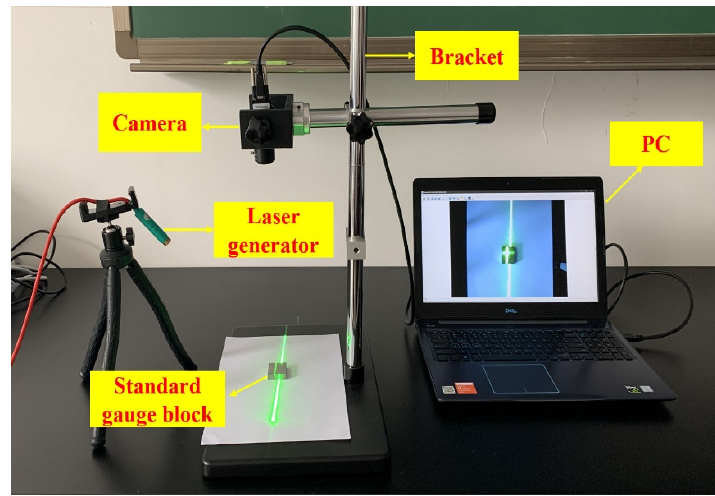
Figure 8. Measurement experiment diagram.